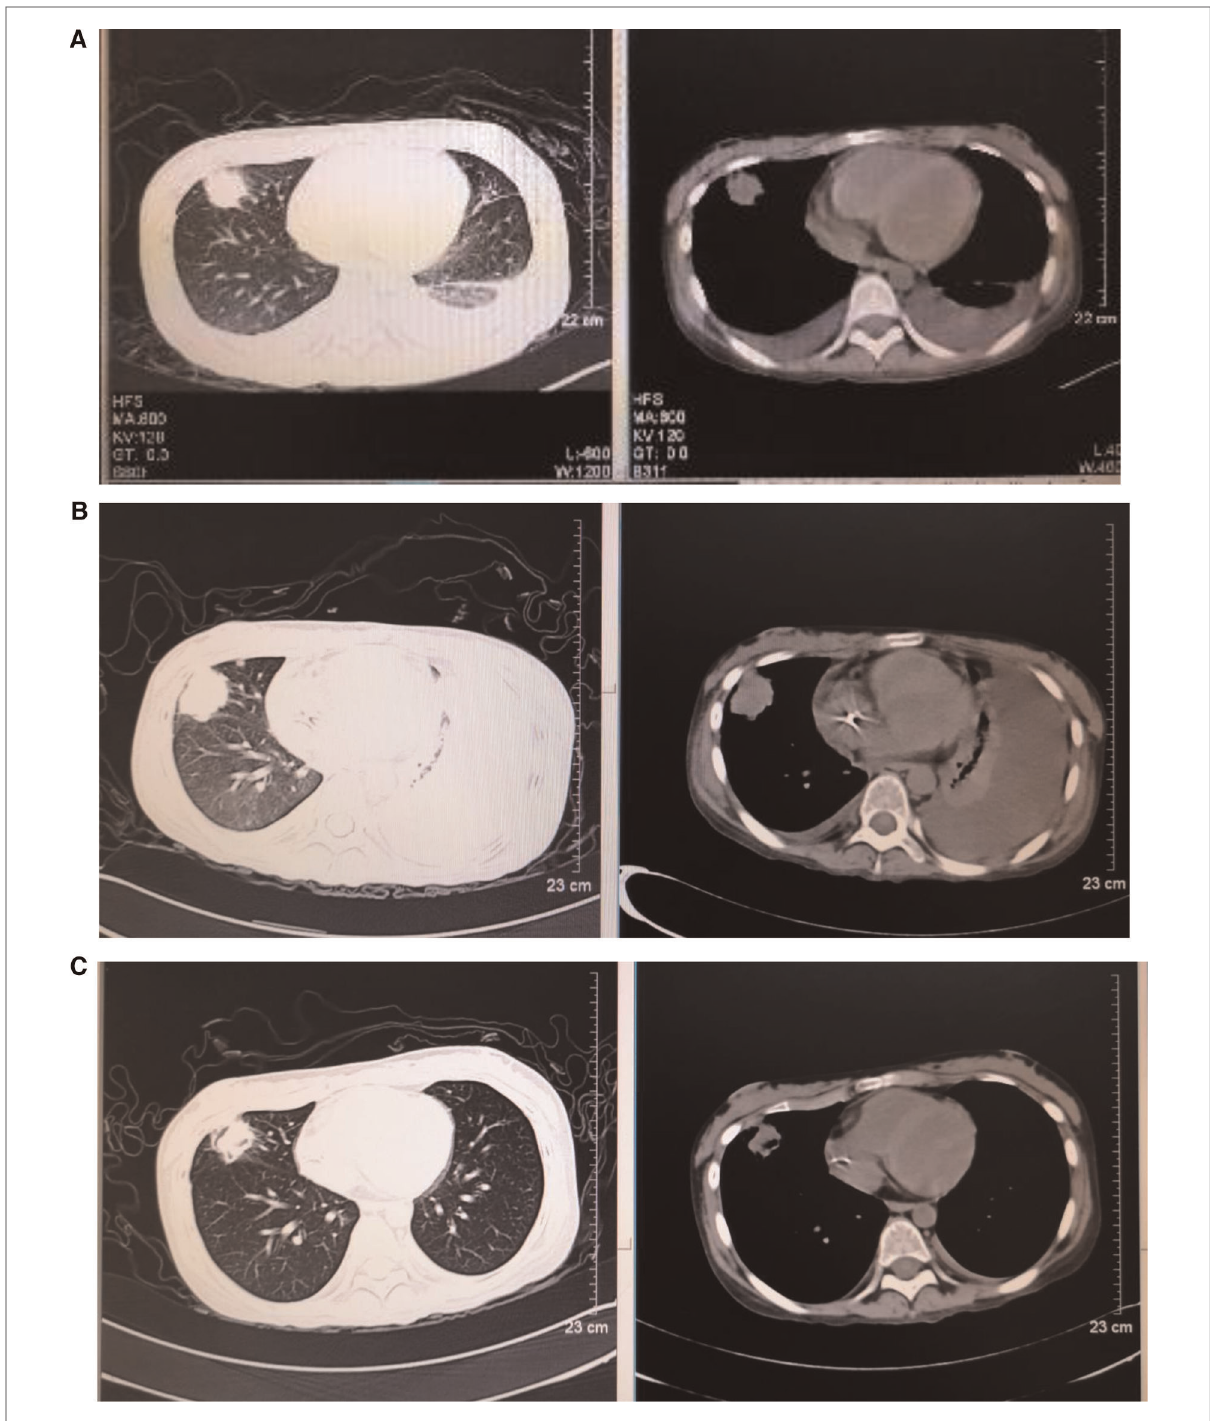
FIGURE 2 Dynamic images of pneumonia before and after transplantation ( A – C ). Chest high-resolution computed tomography: ( A ) 3.3×2.7 cm nodular shadow in the right upper lung, with bilateral pleural effusion on day − 7 before HSCT, ( B ) 3.3×3.1 cm nodular shadow in the right upper lung, with bilateral pleural effusion and left atelectasis on day +22 after HSCT, and ( C ) 2.3×2.0 cm nodular shadow in the right upper lung on day +59 after